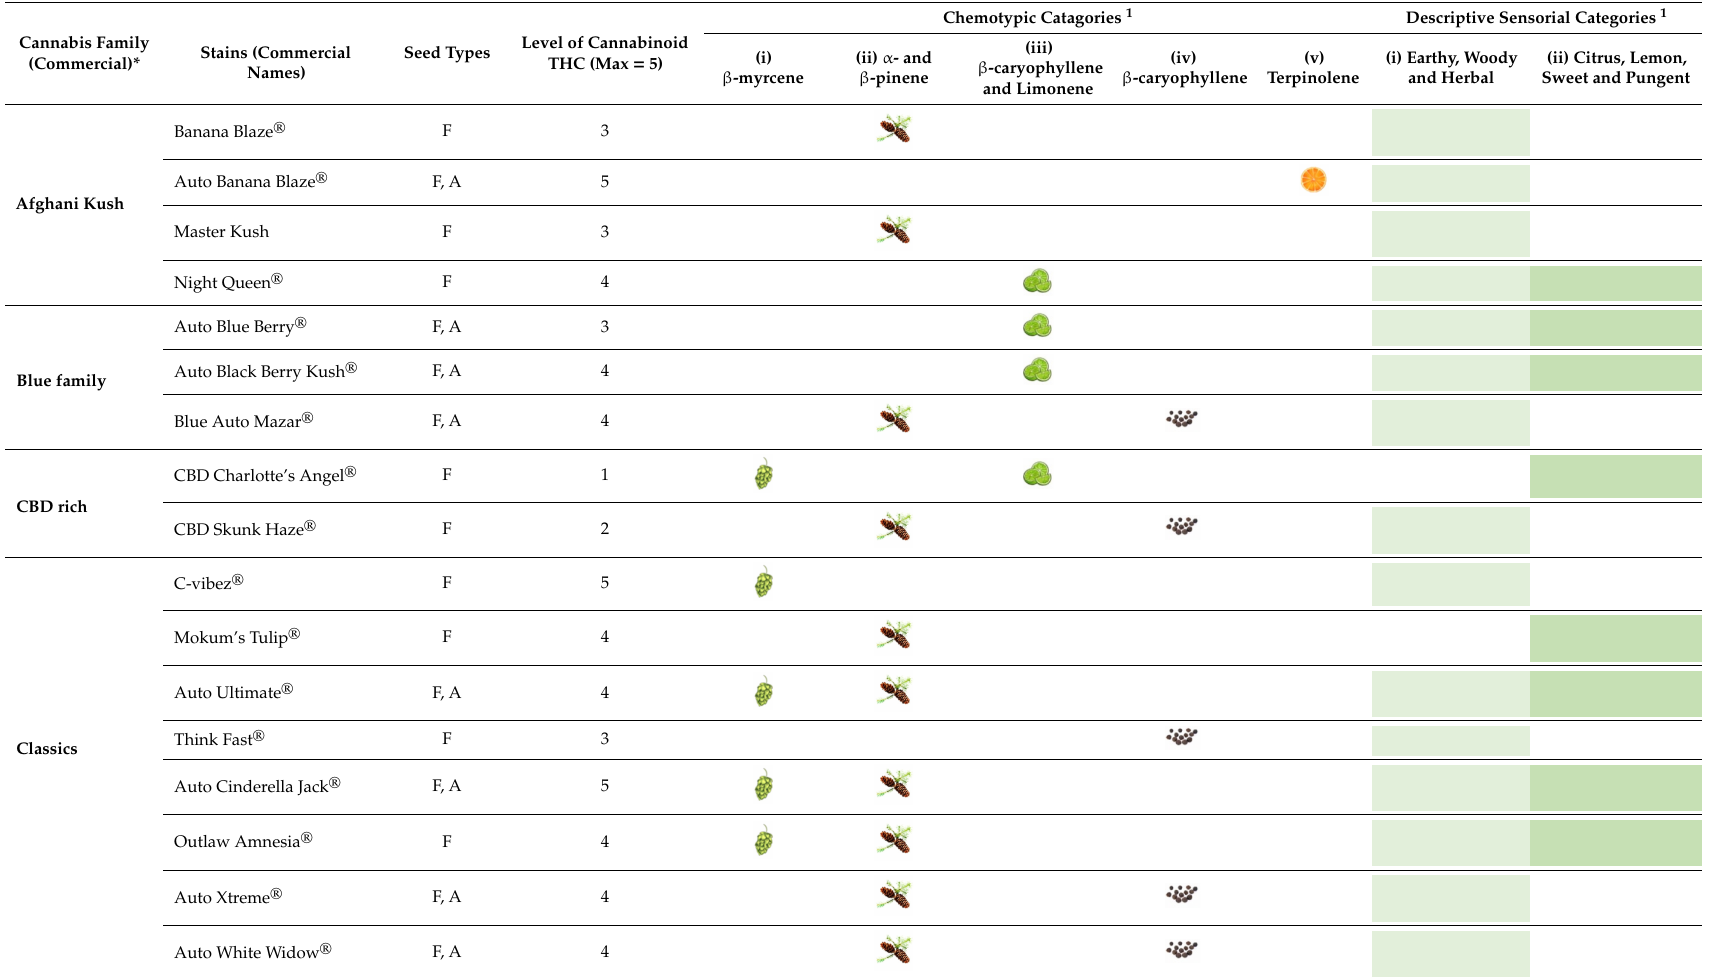
Table 2. Terpene profile category of di ff erent commercial cannabis